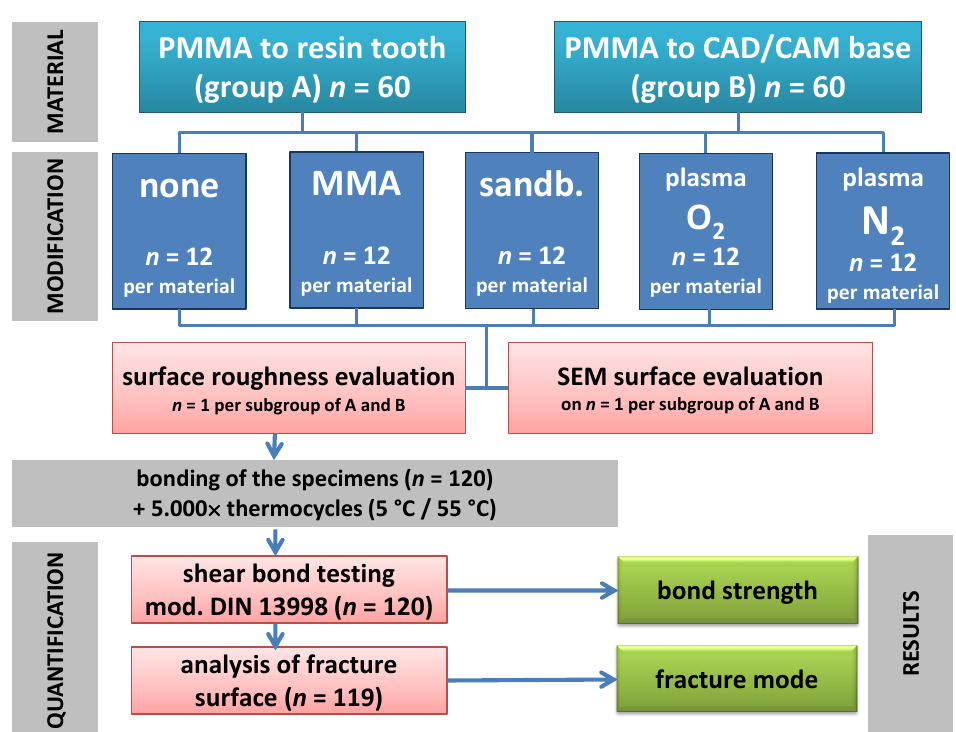
Figure 3. Overview of the study measures in both groups (A and B) resulting in 5 subgroups by surface treatment prior to mating.